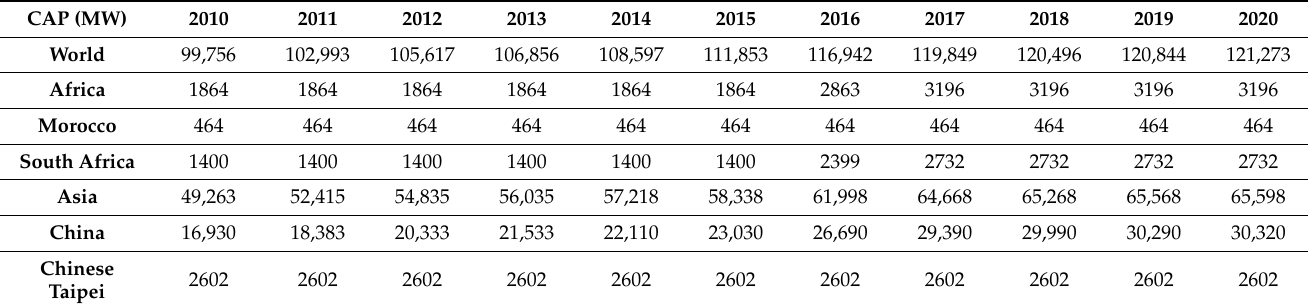
Table 3. Statistics on pure pumped hydro storage (PHS) in the world